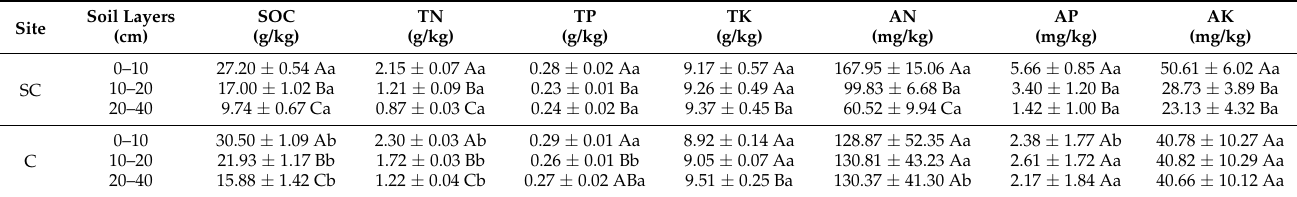
Table 1. Soil characteristics for moso bamboo in strip clearcutting (SC) or unharvested (C) plots.